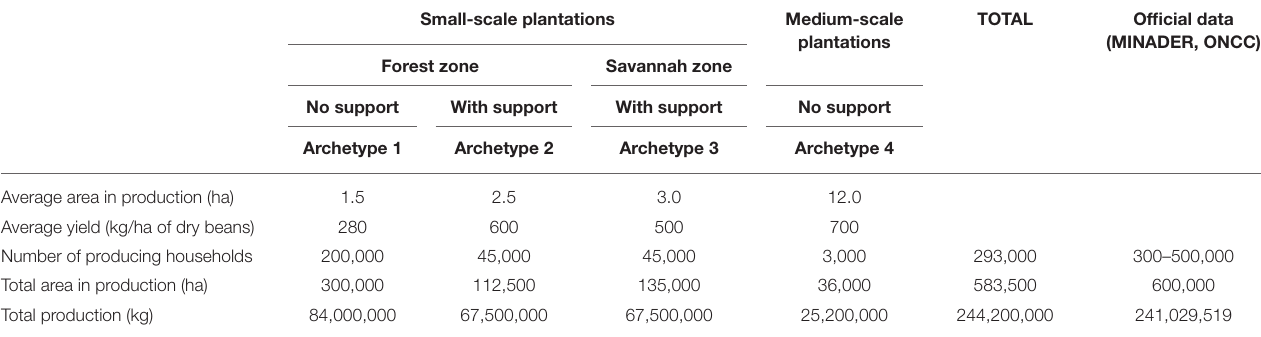
TABLE 2 | Contributions of producer archetypes to national cocoa supply in Cameroon in